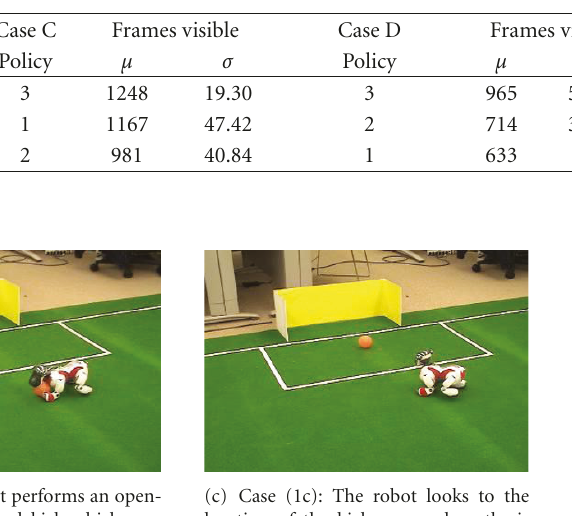
Table 5: Results of the 2D-simulated soccer simulation experiment showing a list of the policies ordered from best (top) to worse (bottom) based on the time the ball is in view for the four di ff erent experimental cases. Time is measured in frames of video where the ball is visible (frame rate is 33Hz). Every result is statistically significant (based on t -test), except for the times of policies 1 and 3 in case B.